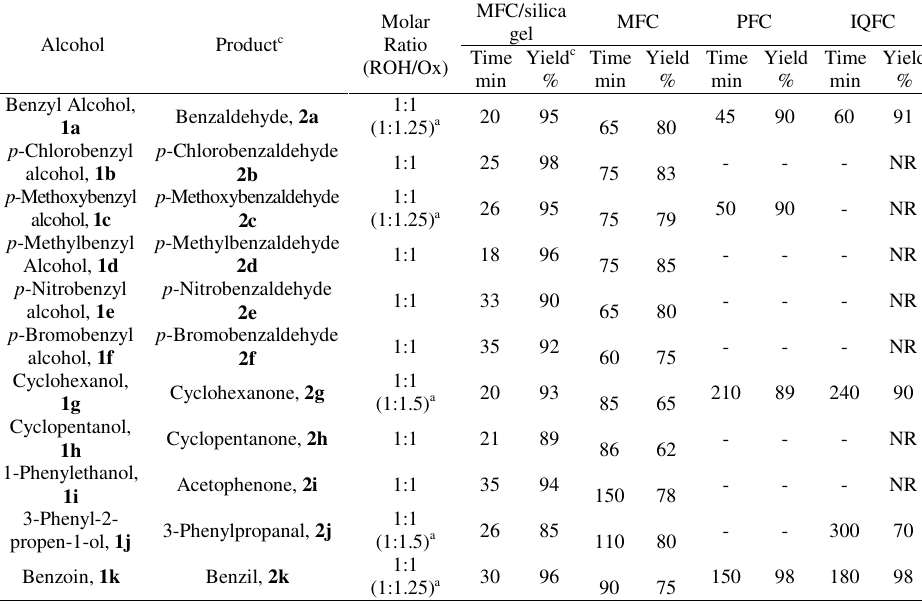
Table 1. Oxidations by MFC/silica gel, MFC, PFC a and IQFC